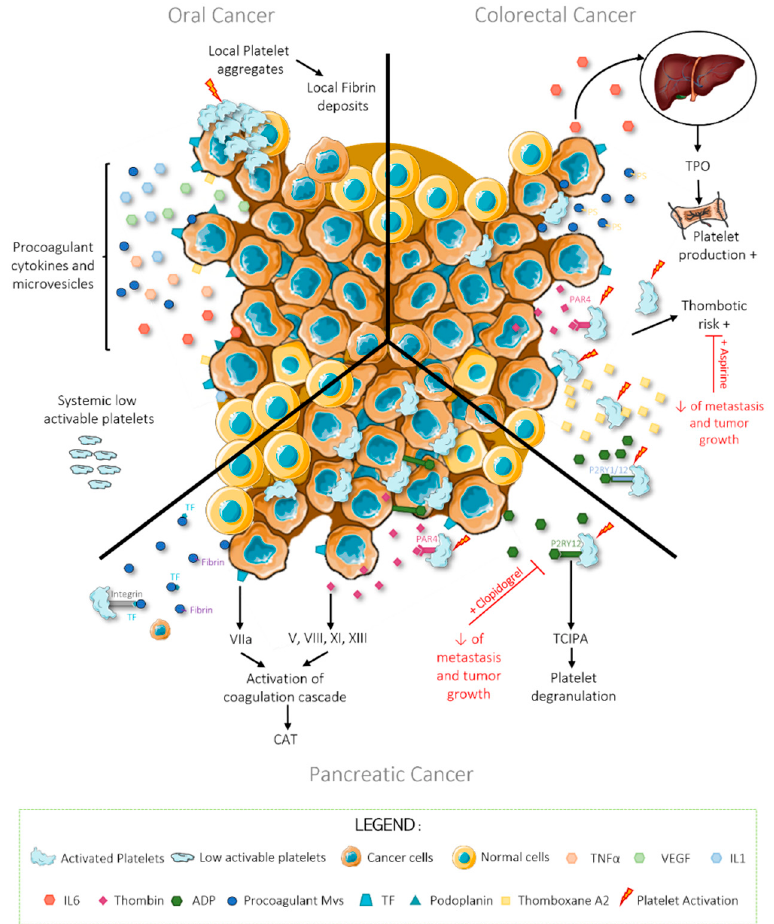
Figure 2. Comparison of cancer-cell–platelet interactions in three different cancer types with low (oral cancer), medium (colorectal cancer), and high (pancreatic cancer) thrombotic risk. Figure created using Servier Medical Art available at http://smart.servier.com, accessed on 15 December 2021.